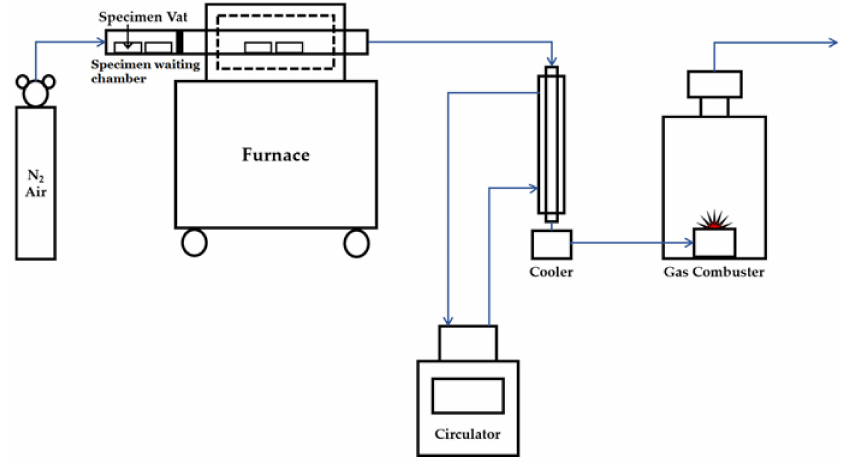
Figure 1. The pyrolysis reactor design